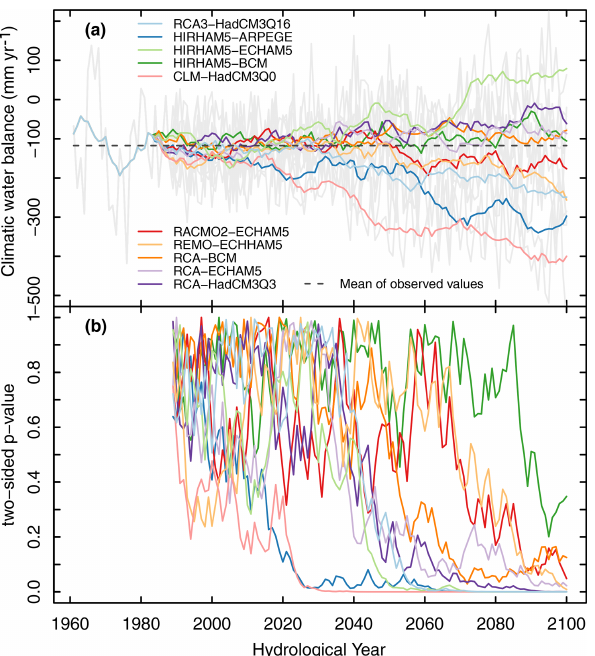
Figure 7. (a) Climatic water balance of 10 climate simulations of different models for the station Geisenheim (Rheingau), Germany, per hydrological year (1 November–31 October) based on the emis- sion scenario RCP8.5. Grey lines show the range of annual values of all models, coloured lines 11-year running means for individual model runs. The period from 1961–1988 shows observed data. The (b) p values calculated with Mann–Kendall trend test for time series shown in (a) starting in 1961.